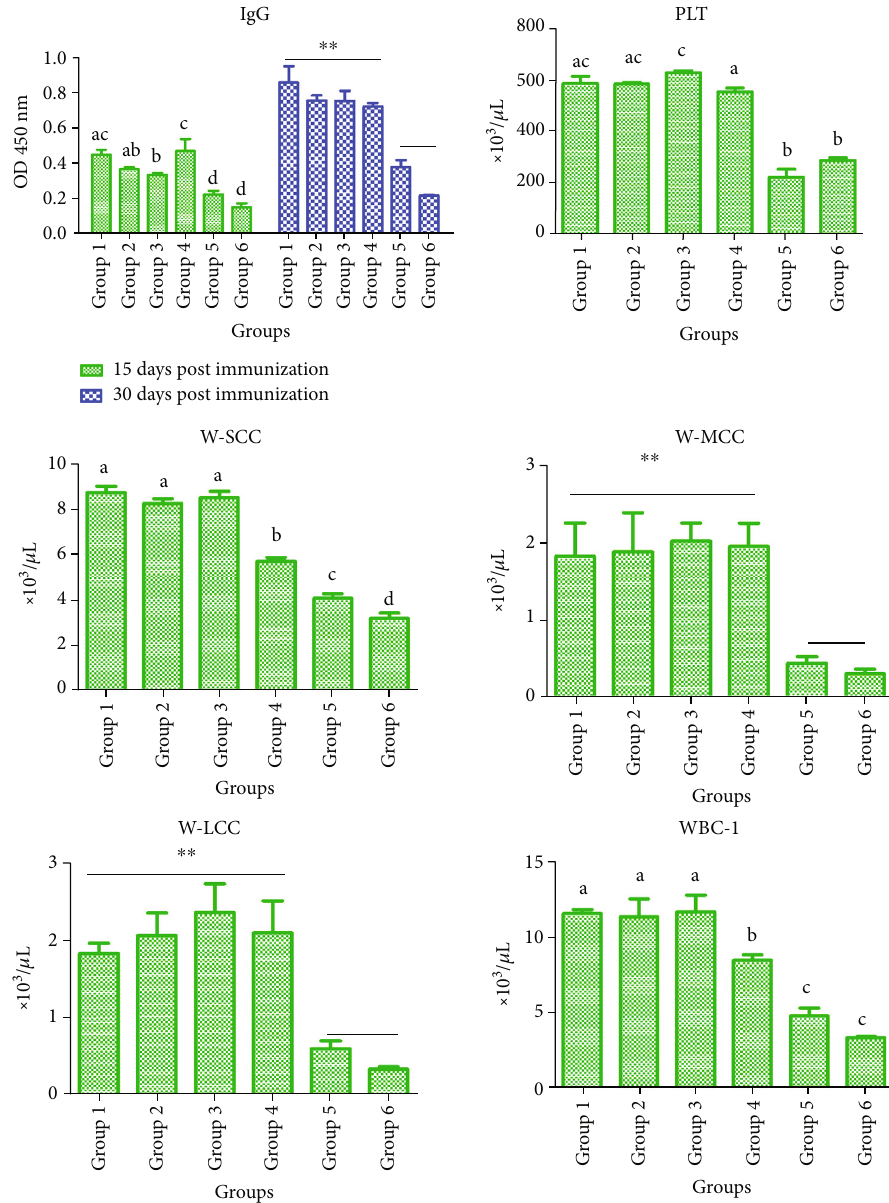
Figure 2: The serum level of whole bacterial protein-speci fi c IgG antibody in rabbits from Experiment B was detected by indirect ELISA at 15 and 30 days postinjection. Blood samples were collected as anticoagulants at 15 days after injection for the detection of PLT, SCC, MCC, LCC, and